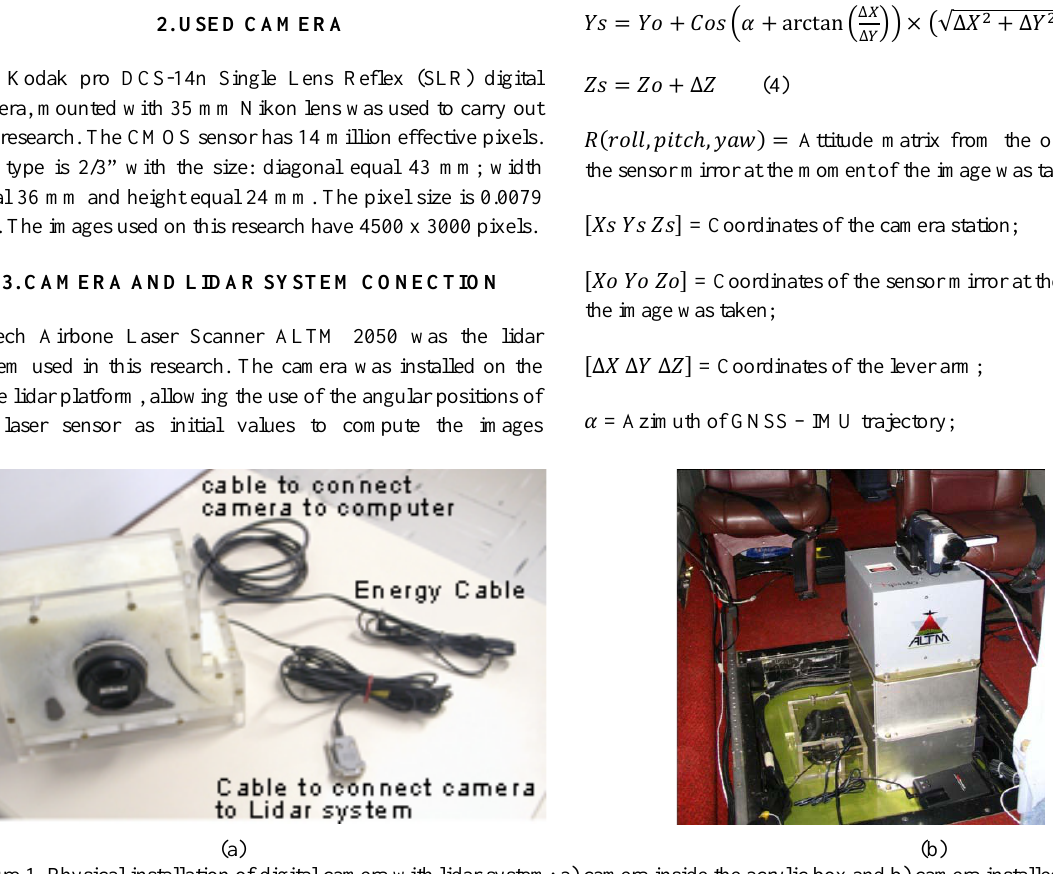
Figure 1. Physical installation of digital camera with lidar system: a) camera inside the acrylic box and b) camera installed in the lidar